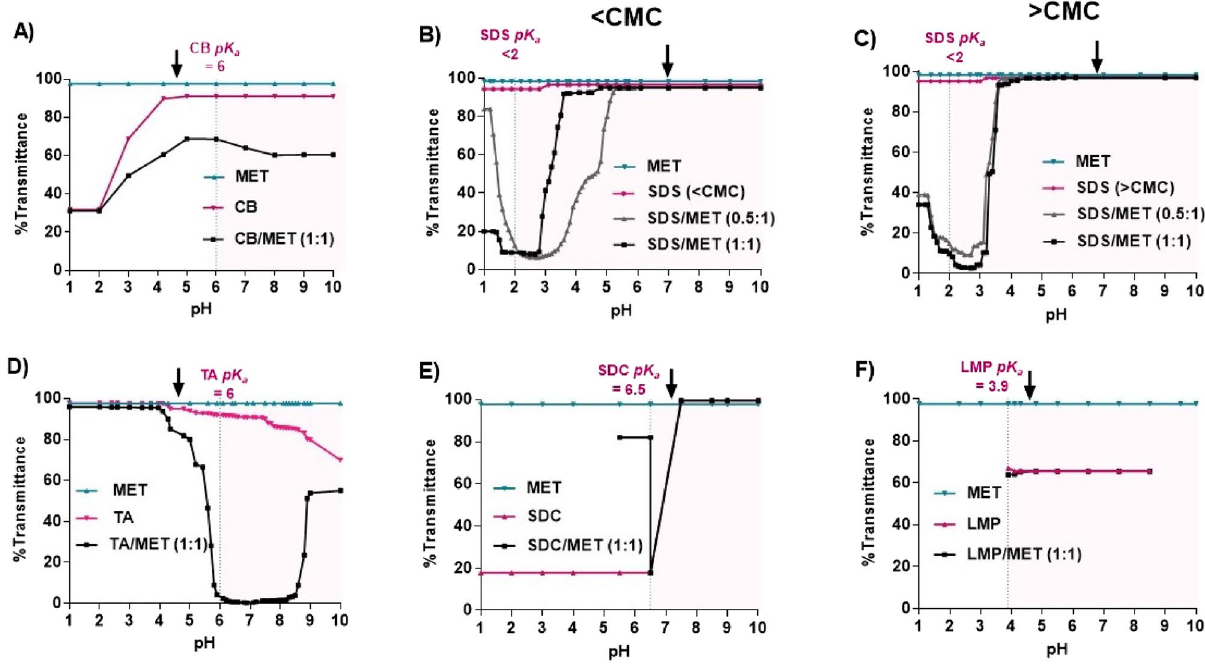
Figure 2. %Transmittance change versus pH for metformin hydrochloride (MET) with different ligands. ( A ) Carbopol (CB), ( B ) Sodium dodecyl sulfate (SDS) below critical micelle concentration (CMC), ( C ) SDS above CMC, ( D ) Tannic acid (TA), ( E ) Sodium deoxycholate (SDC), and ( F ) Low molecular weight pectin (LMP), compared to free MET and free ligand solutions. Black arrows show starting pH of ligand/MET mixture before pH adjustment. The pink plot area shows the pH range where both MET and ligand are